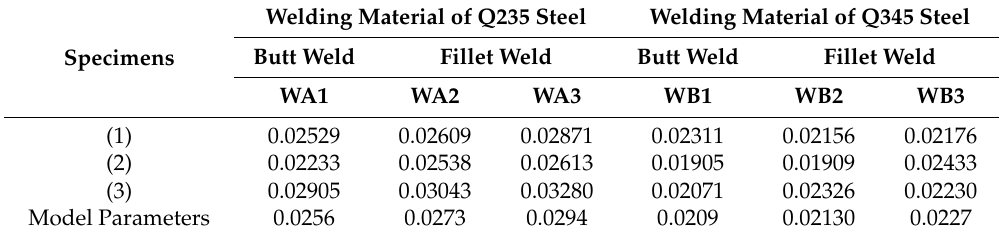
Table 6. Values of Parameter λ .